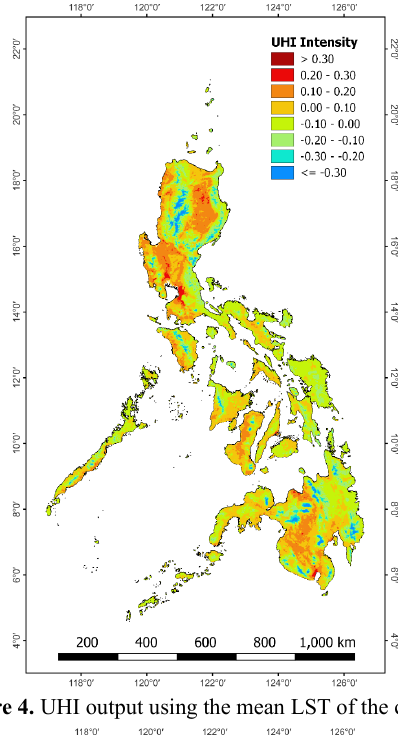
Figure 4. UHI output using the mean LST of the country